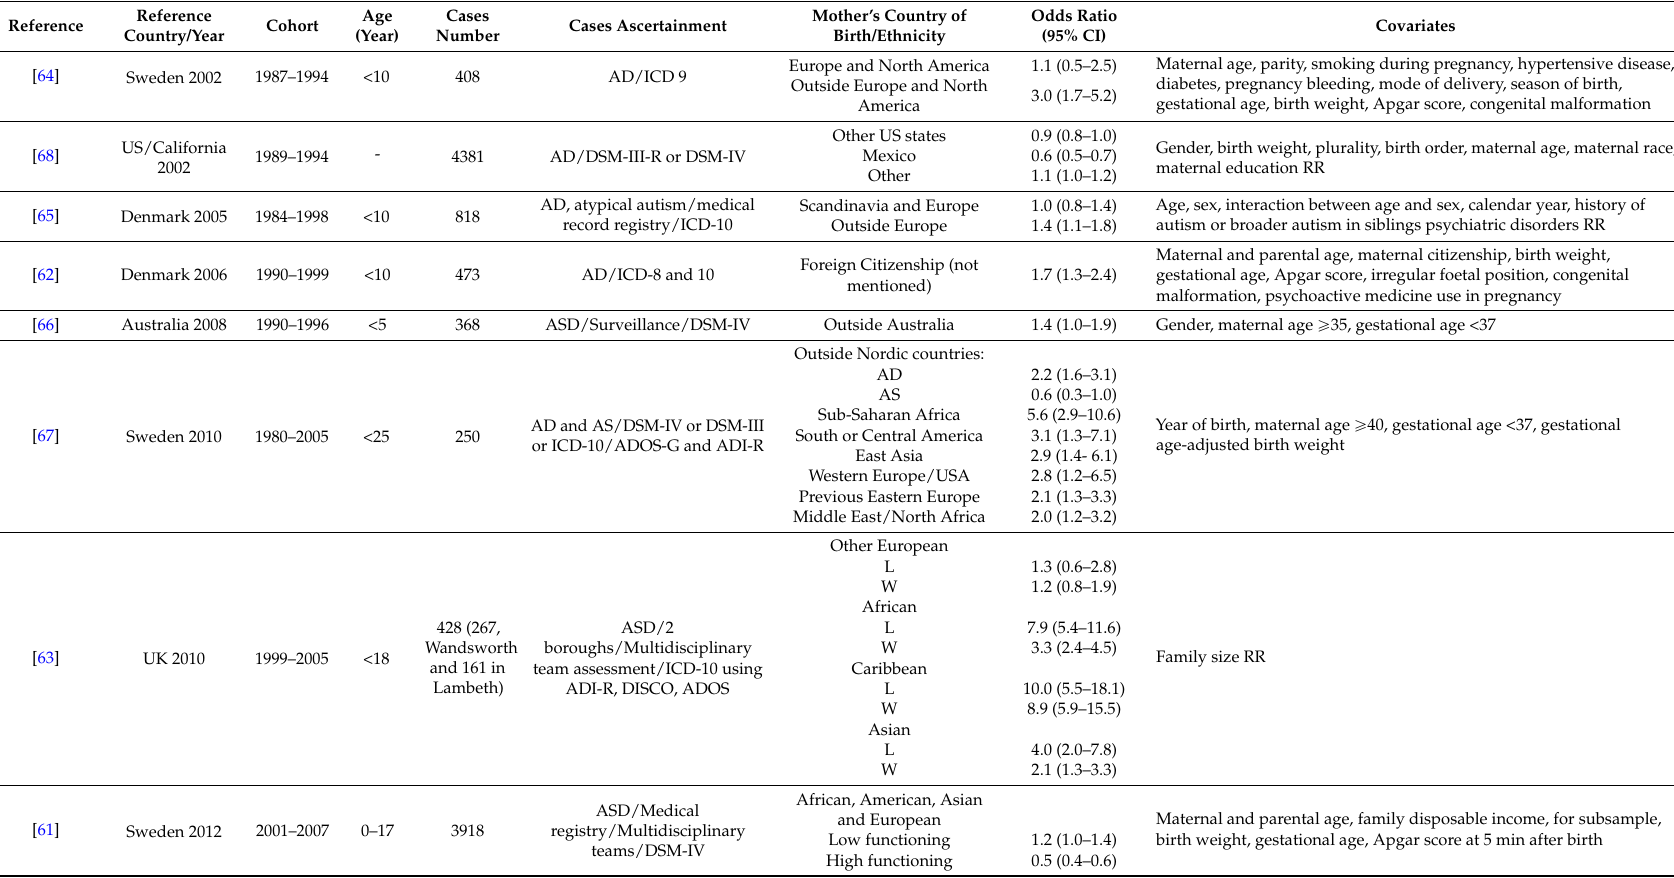
Table 2. Risk of autism in mothers born outside the reference country and according to mothers’